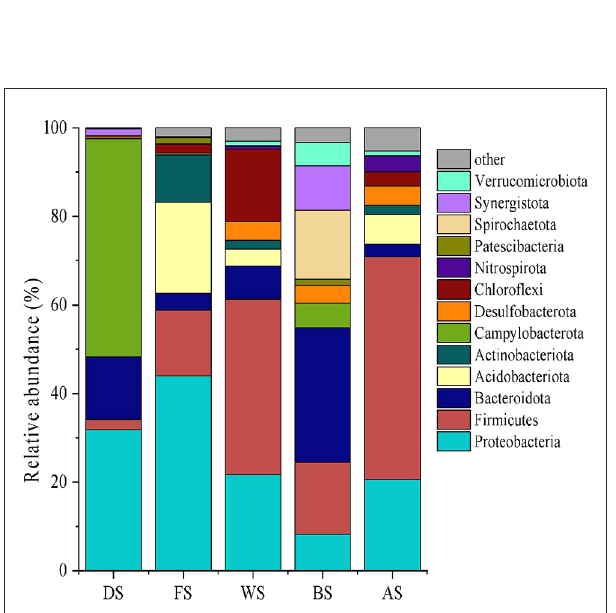
FIGURE5 The non-metric multidimensional scaling analysis (NMDS) of bacterial community composition based on the Bray–Curtis dissimilarity matrix (FS, industry; DS, urban land; AS, culture ponds; BS, livestock; WS,